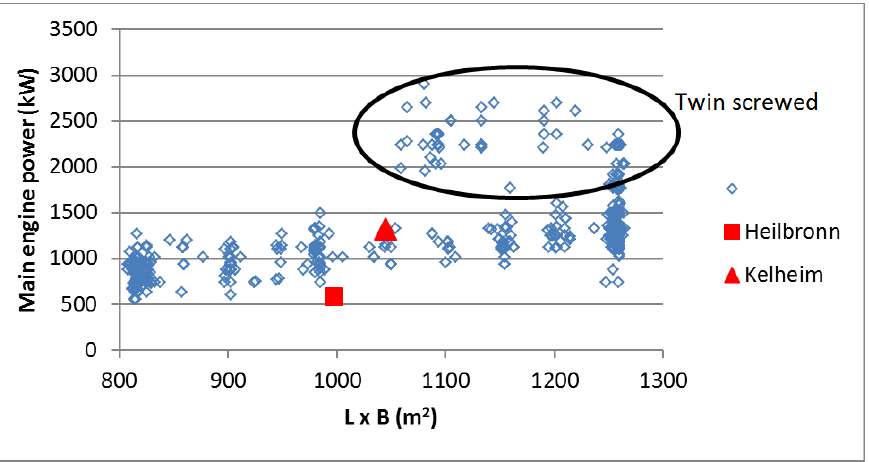
Figure 2. Power vs. dimensions of inland